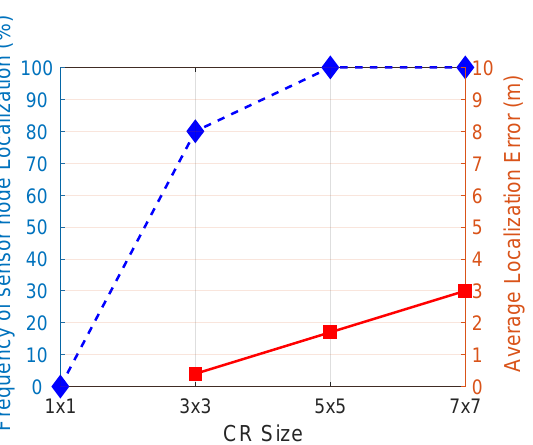
Figure 16. Shows the effect of size of correlation region to probability of success of localization and localization accuracy.